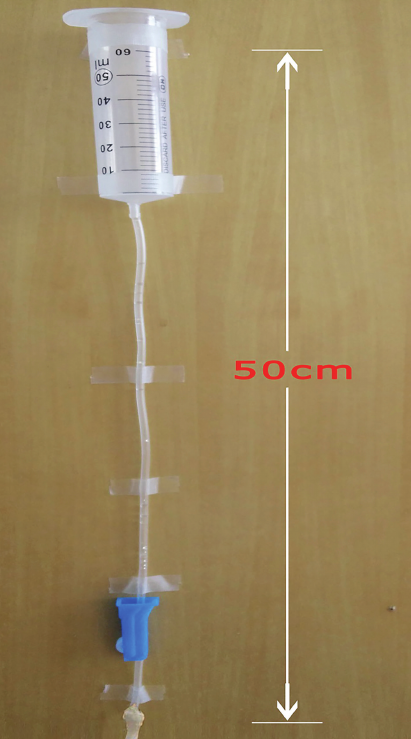
Figure 2 - A simple flow rate